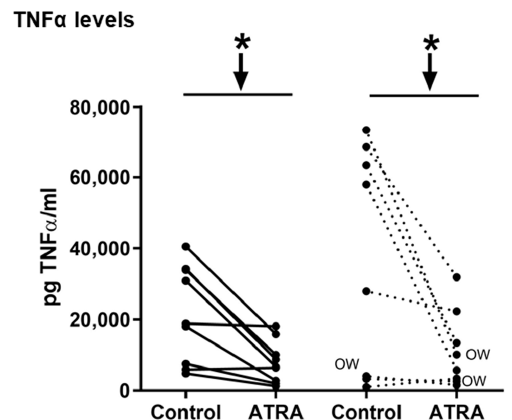
Figure 4. E ff ect of ATRA (10 µ M) treatment on isolated PBMCs on IL6 and TNF α levels in the culture Figure 4. Effect of ATRA (10 µM) treatment on isolated PBMCs on IL6 and TNF α levels in the culture media. In the overweight-obese group, one culture media sample was missing, and thus only 8 out of 9 samples were measured. Additionally, also in this group, one outlier data was discarded for IL6 levels. Cytokine concentrations were detected by ELISA. All data are presented as individual responses and represent means of 2 duplicates per subject. * p < 0.05 was calculated using a paired t -test. Two-way repeated measures ANOVA was performed to compare the di ff erent e ff ect of treatments and body weight on gene expression. No interactive e ff ect between treatment and body weight of PBMC donors was found (detailed results are shown in Table 2B). OW indicates the overweight subjects within individuals of the overweight-obese group. Down arrows represent decreased